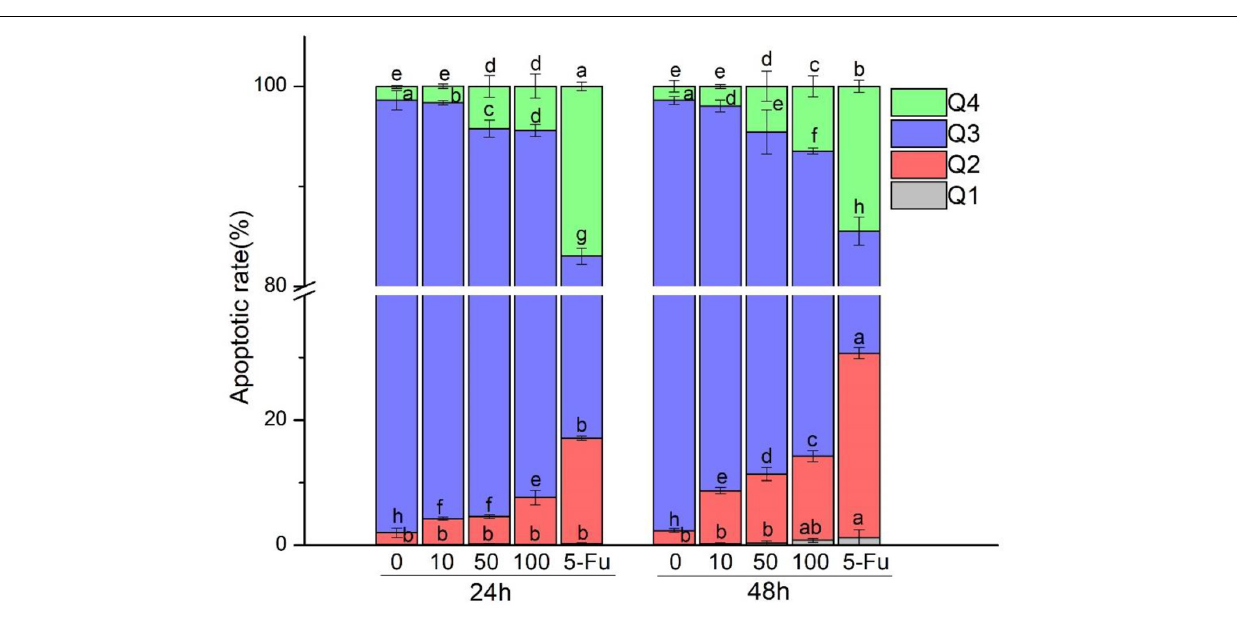
FIGURE 3 | Effect of L. acidophilus KLDS1.0901 on apoptosis of HT-29 cells. L. acidophilus KLDS1.0901 were incubated in HT-29 cells of different MOI (0, 10, 50, and 100) and 5-FU (100 µ mol/L) for 24 and 48 h. Q1–Q4 represents necrotic cells, late apoptotic cells, nonapoptotic cells, and early apoptotic